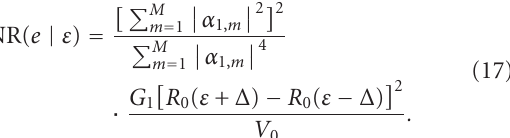
Figure 5: TED output SNRs for di ff erent timing errors.